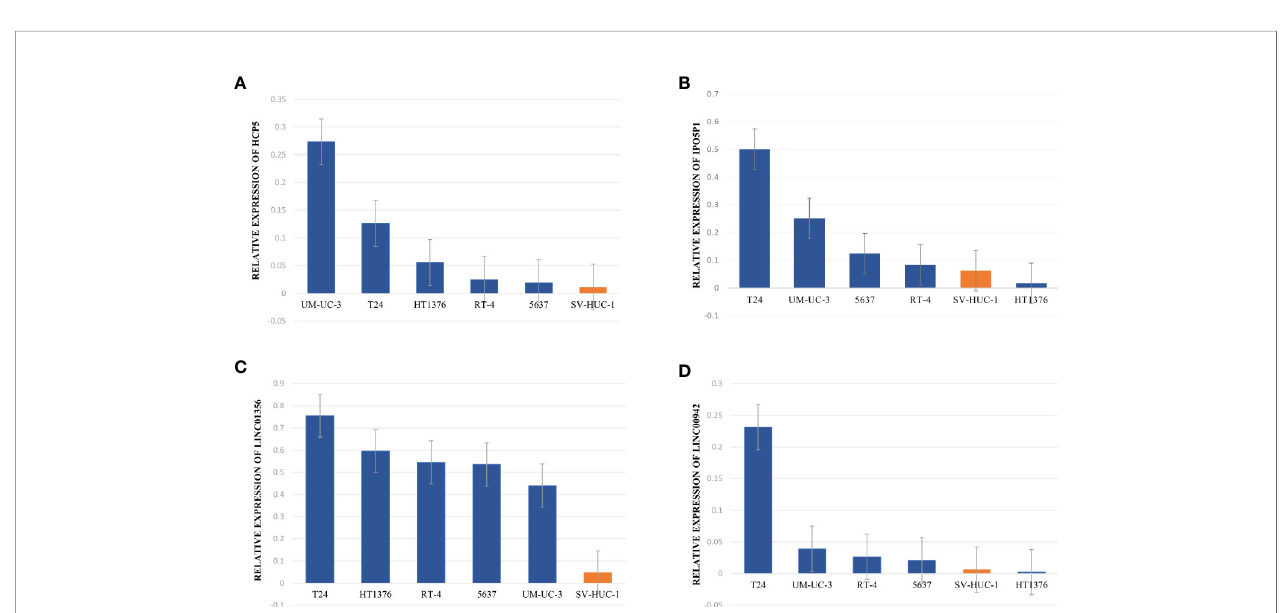
FIGURE 3 | Upregulated expression of four selected lncRNAs in normal urothelium cell compared with BLCA and cell lines. (A – D) qRT-PCR analysis indicates the relative expression level of HCP5 (A) , IPO5P1 (B) , LINC01356 (C) , LINC00942 (D) in distinct BLCA cell lines (T24, 5637, RT-4, UM-UC-3, and HT1376) and normal immortalized urothelium cell SV-HUC-1. The GAPDH allele is used as a loading